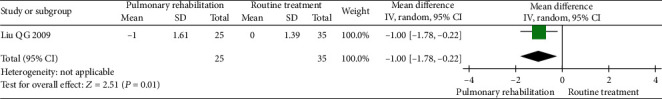
Forest plot showing the effect of PR on the mMRC for pneumoconiosis.